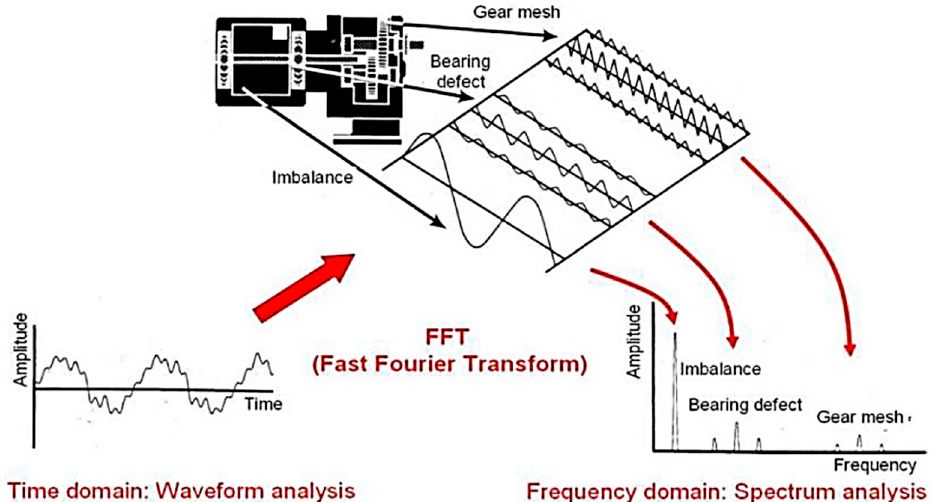
Figure 6. Time and frequency domain analyses for vibration based diagnostic [3].